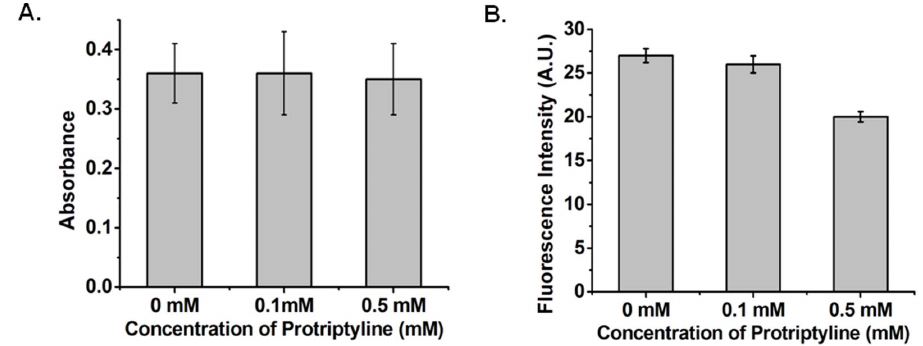
Figure 7. Protriptyline Does Not Affect Other Proteases. Effect of protriptyline on A . Trypsin B . ADAM 17activity. Specific synthetic substrate BA p NA and fluorogenic peptide was used for analyzing activity on trypsin and ADAM 17, respectively. Trypsin activity was unaffected, while ADMA 17 showed weak inhibition in presence of protriptyline.